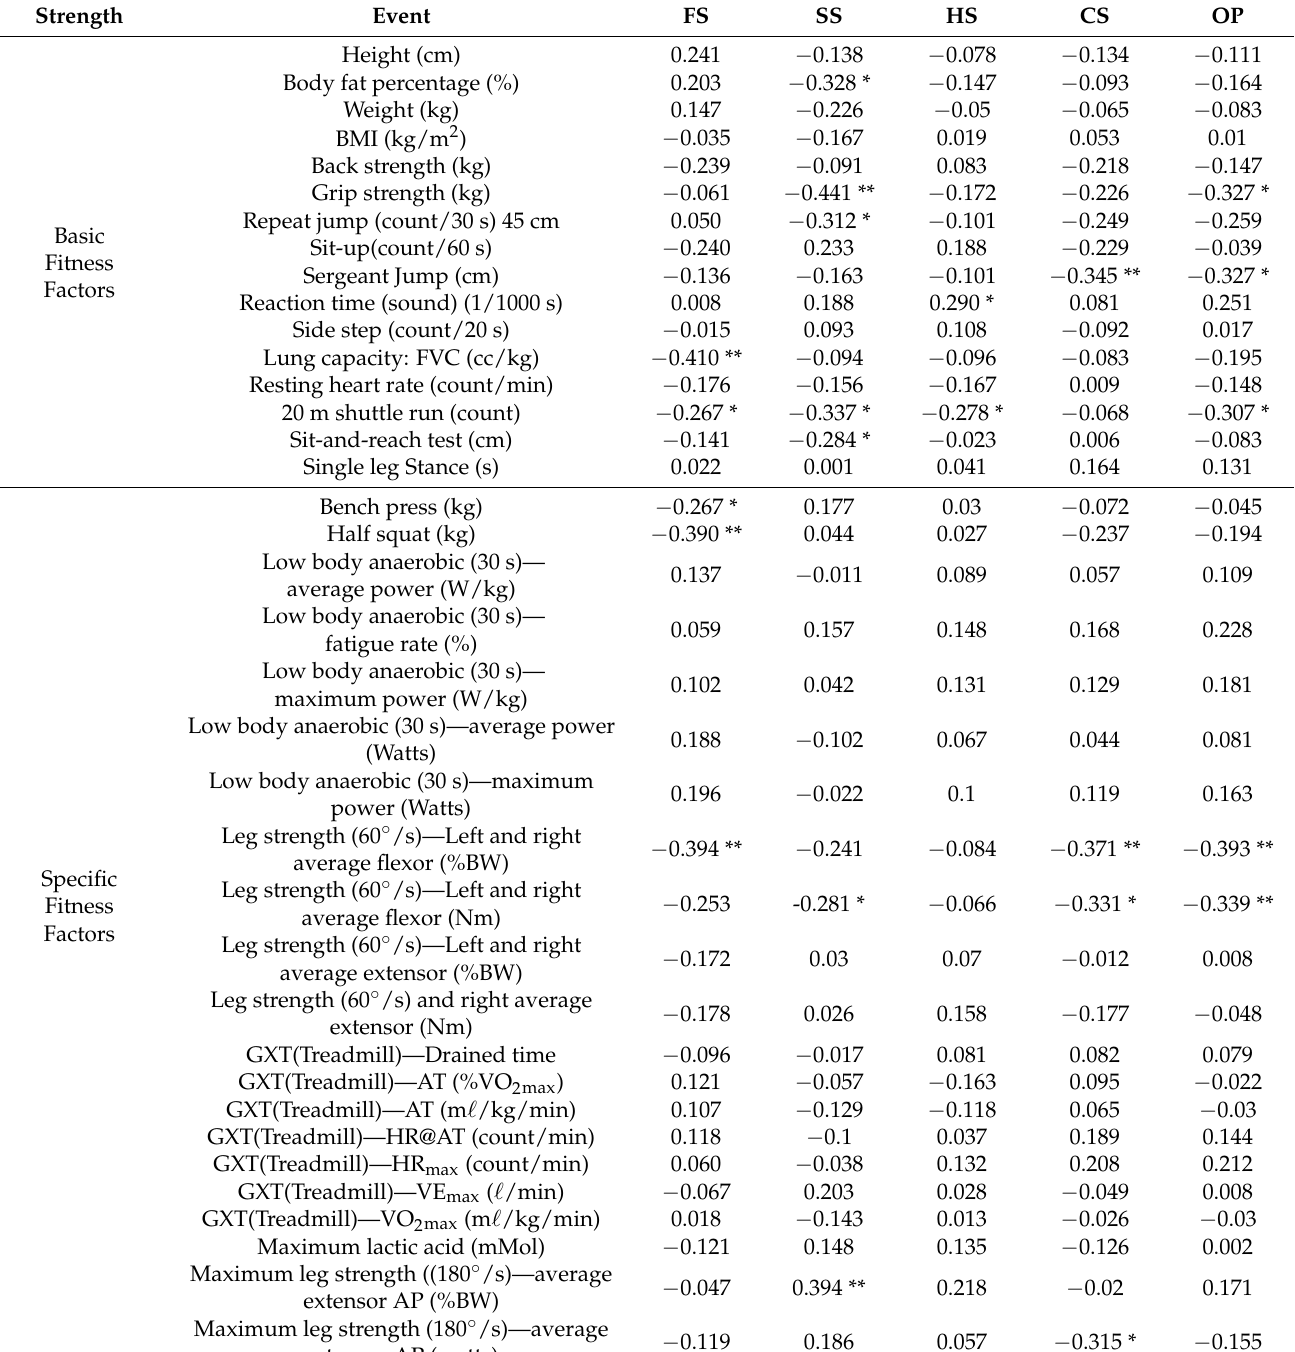
Table 3. Correlation between anthropometric data and physical fitness factors and modern pentathlon and overall perfor- mance in national